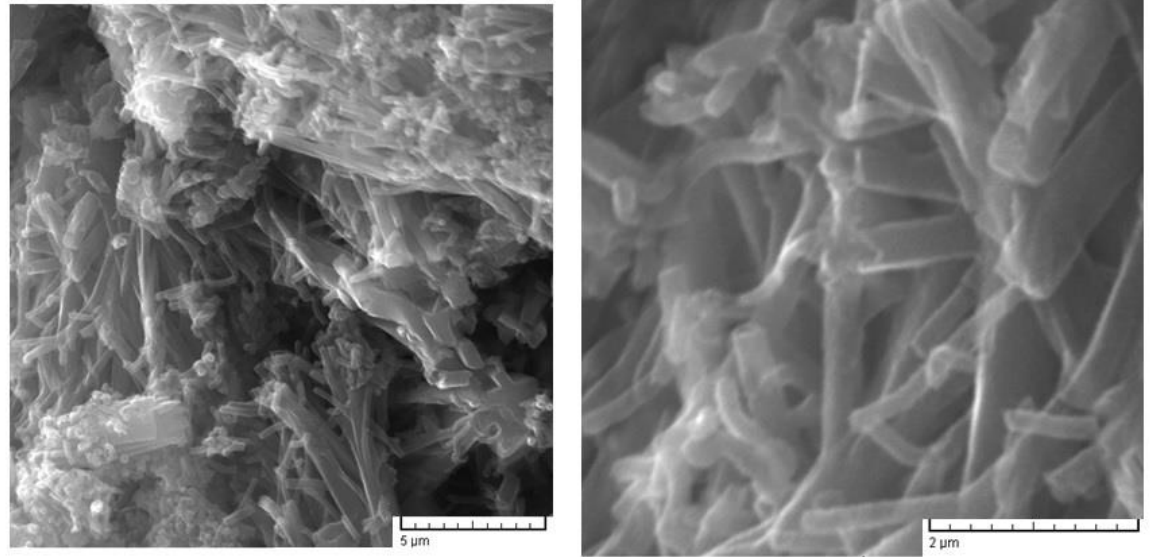
Figure 2. SEM image of PANI with magnitude of 8 kx ( left ) and 30 kx ( right ).